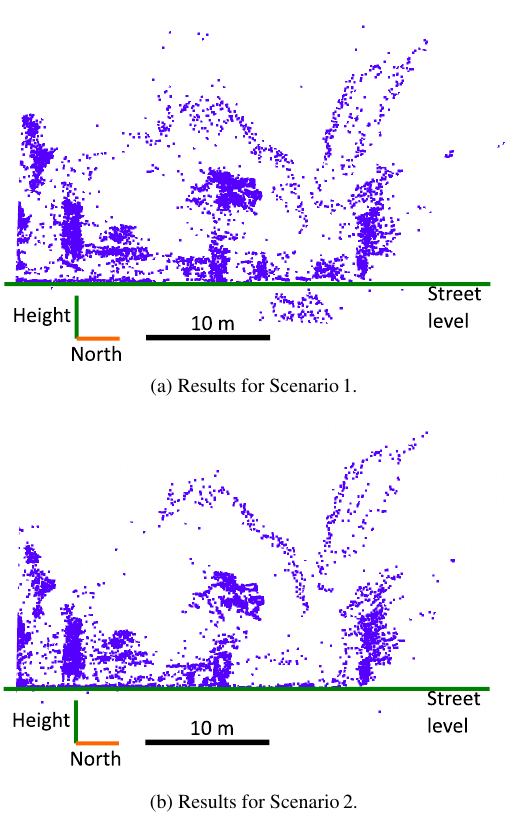
Figure 10. Subset of the 3D point cloud after bundle